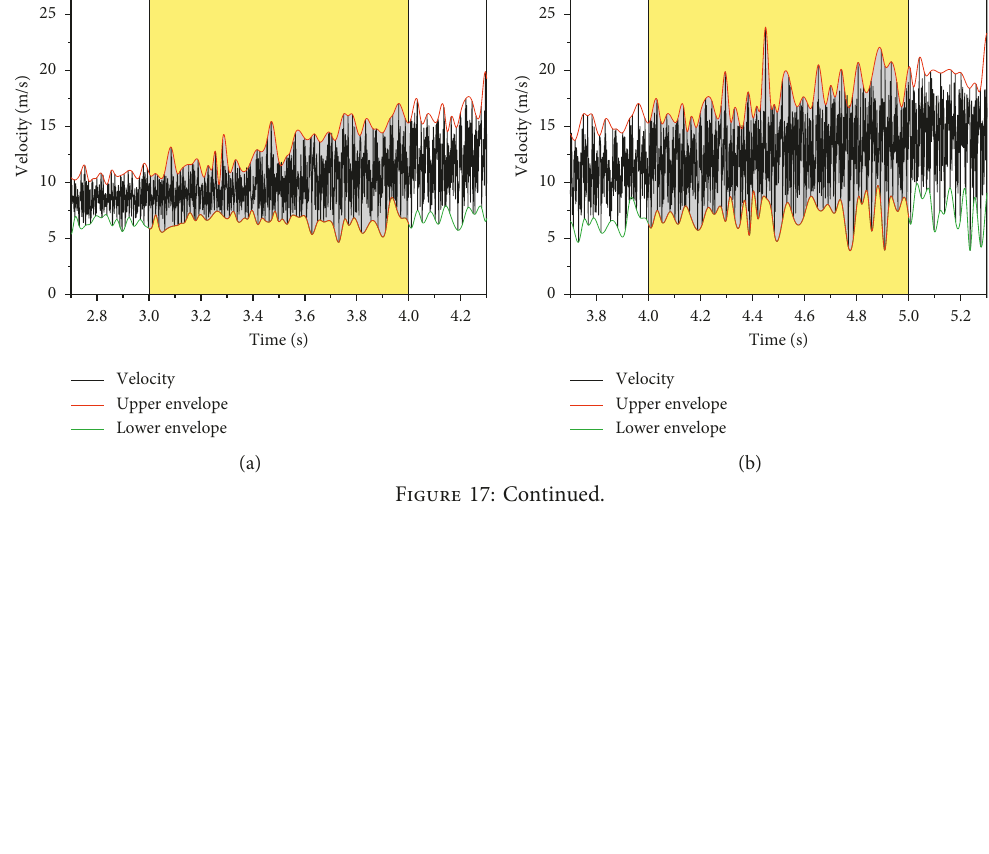
6.3m 3 /h. (d) Found 86 peaks, Q (cid:31)